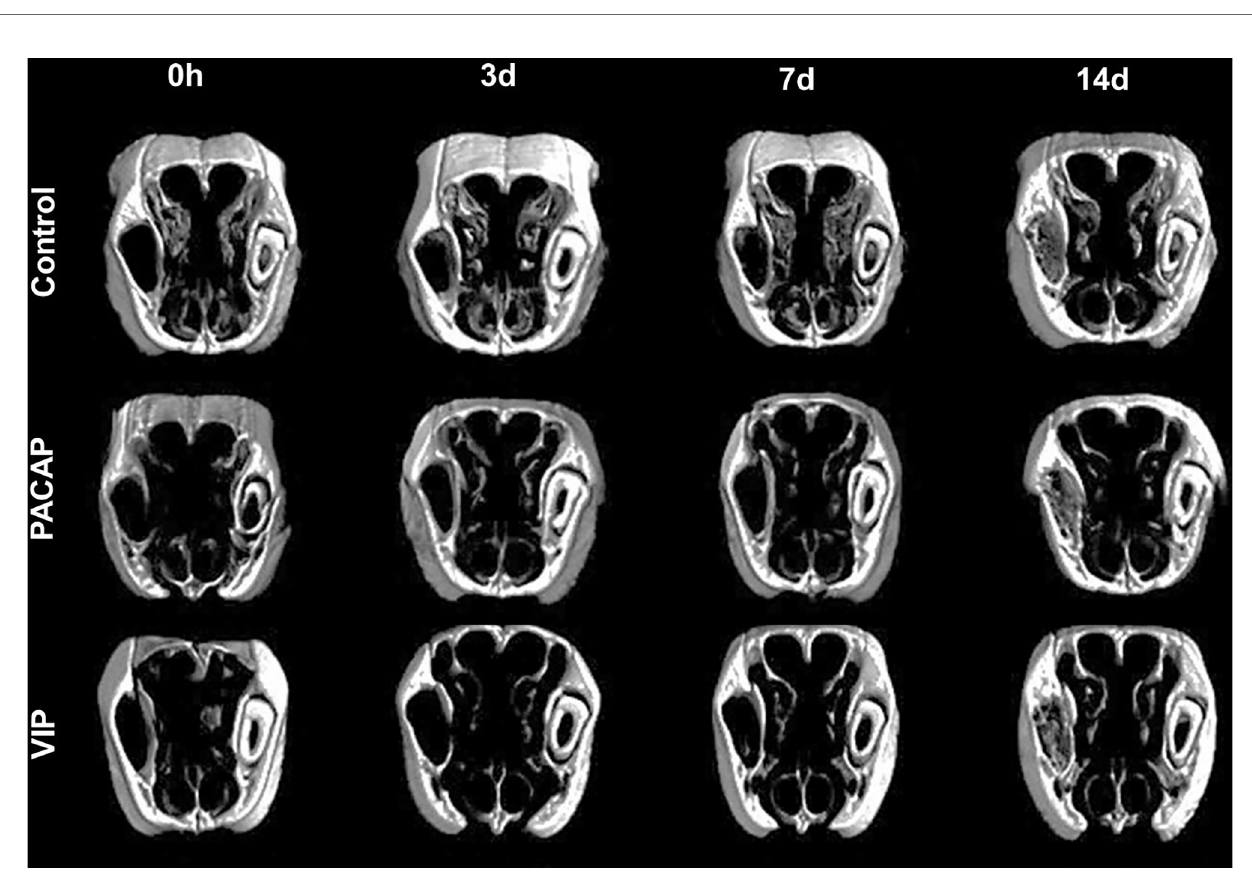
FIGURE 13 | Three-dimensional morphological analysis by µCT of the alveolar bone healing process in mice control and treated with PACAP and VIP in the 0, 3-, 7-, and 14-day post-exodontia periods. The images were reconstructed using the NRecon Reconstruction software and three-dimensional images obtained by the CTvox software. The maxillae were sectioned in the transversal